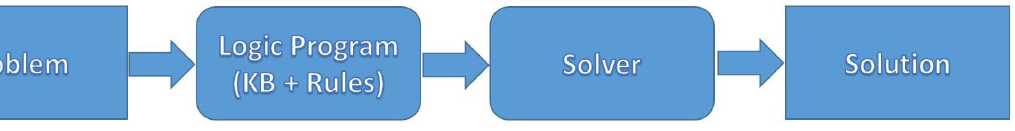
Figure 1. Answer Set Programming solving